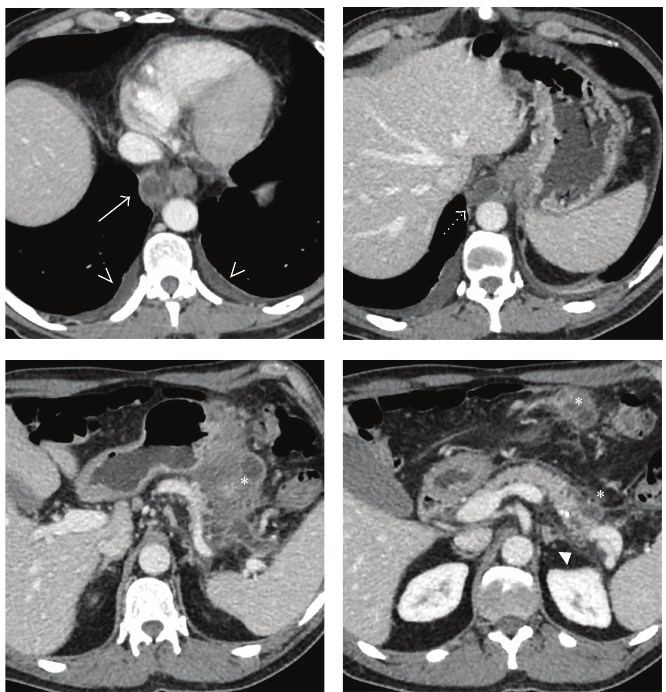
Figure 1: Axial images of contrast-enhanced CT show peripancreatic fluid collections and their mediastinal extension (white arrow). CT images show a cystic mass in the mediastinum, posterior to heart and right to the thoracic aorta (dotted arrow). At inferior level, fluid collections extend as a long vertical cystic lesion along the greater curvature of the stomach up to the pancreatic tail and to the greater omentum (asterisk) with increased thickening of the perirenal fascial planes (arrowhead) and stranding in the fat surrounding the fluid collections. Small amount of pleural effusion was detected in both thoracic cavities